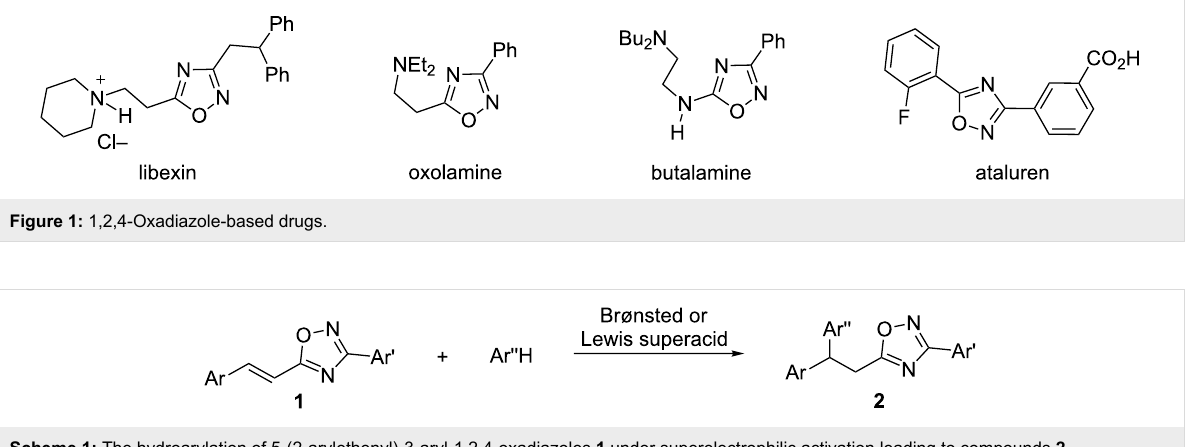
Scheme 1: The hydroarylation of 5-(2-arylethenyl)-3-aryl-1,2,4-oxadiazoles 1 under superelectrophilic activation leading to compounds 2 .